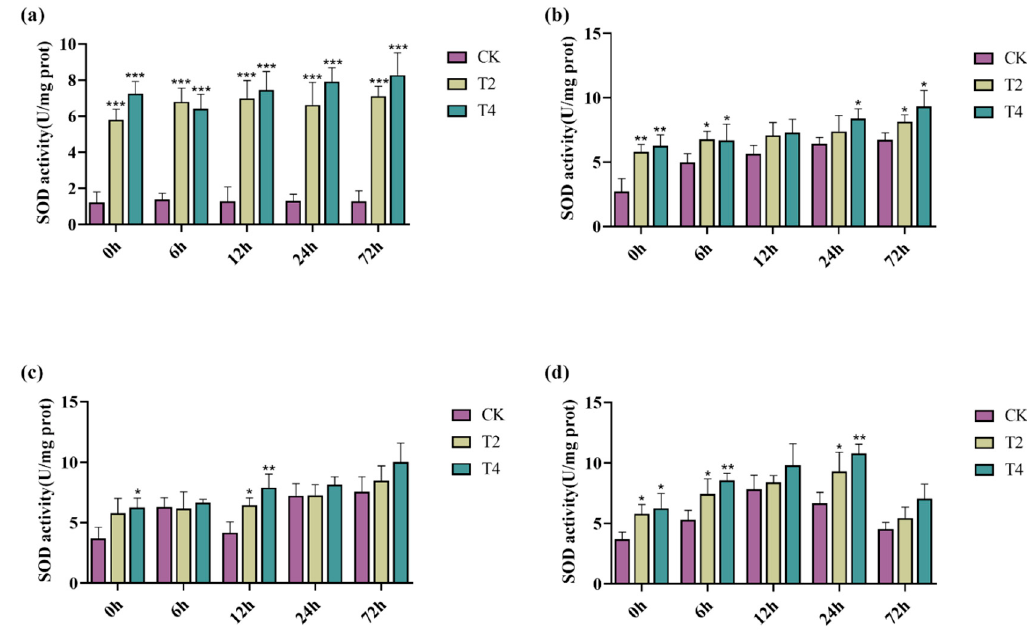
Figure 6. SOD activity of transgenic and non-transgenic poplar plants subjected to different NaCl concentrations. Note: ( a ) without NaCl; ( b ) 100 mM NaCl; ( c ) 200 mM NaCl; and ( d ) 300 mM NaCl (The “*” above the histogram indicates significance. “*” indicates p < 0.05, “**” indicates p < 0.01, and “***” indicates p < 0.001).